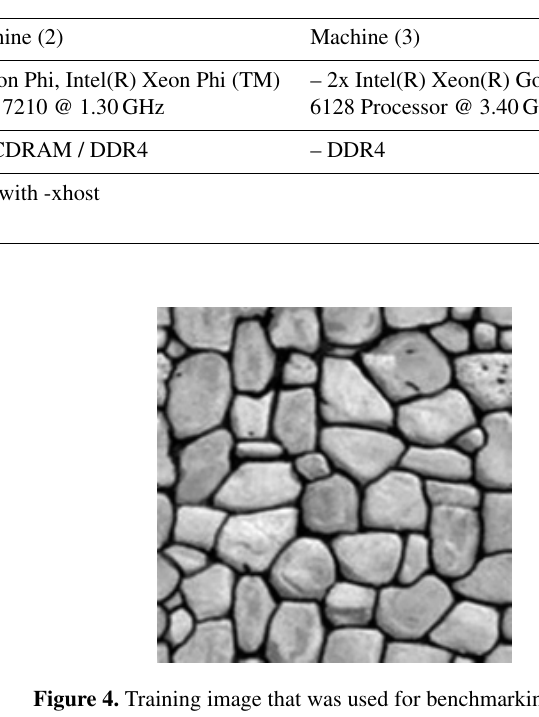
Table 2. Hardware that was used in the experiments.